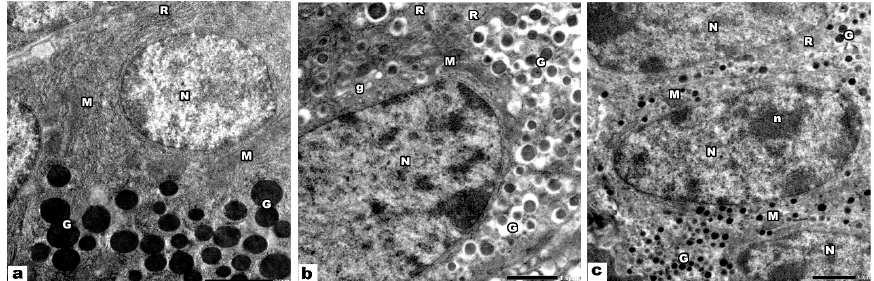
Figure 3. Electron micrograph of control pancreatic sections. ( a ) The acinar cells have basal, rounded, euchromatic nuclei (N), cytoplasm shows parallel cisternae of rough endoplasmic reticulum (R), mitochondria (M), and electron-dense granules (G). ( b ) β cells of the islets of Langerhans have euchromatic nuclei (N), and its cytoplasm is occupied by many electron-dense granules (G) encircled by clear space, mitochondria (M), rER (R), and golgi apparatus (g). ( c ) α cells have euchromatic nuclei (N) with prominent nucleoli (n), its cytoplasm is occupied by many electron-dense granules (G), rough endoplasmic reticulum (R), and mitochondria